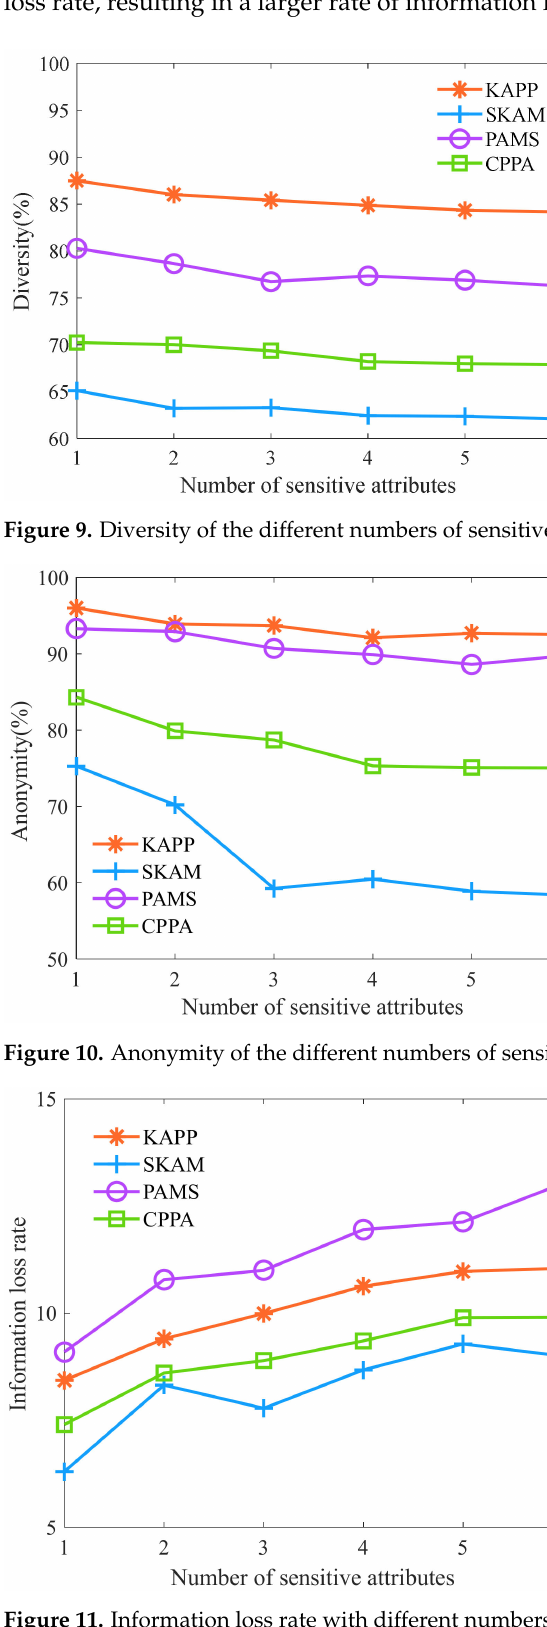
Figure 11. Information loss rate with different numbers of sensitive